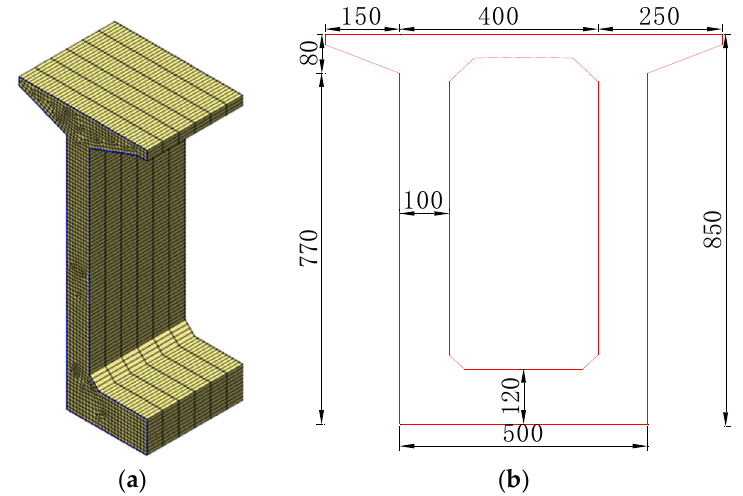
Figure 1. Finite element model and sizes of the concrete box girder. ( a ) Half of finite element model of concrete box girder. ( b ) Sectional sizes of box girder/cm.